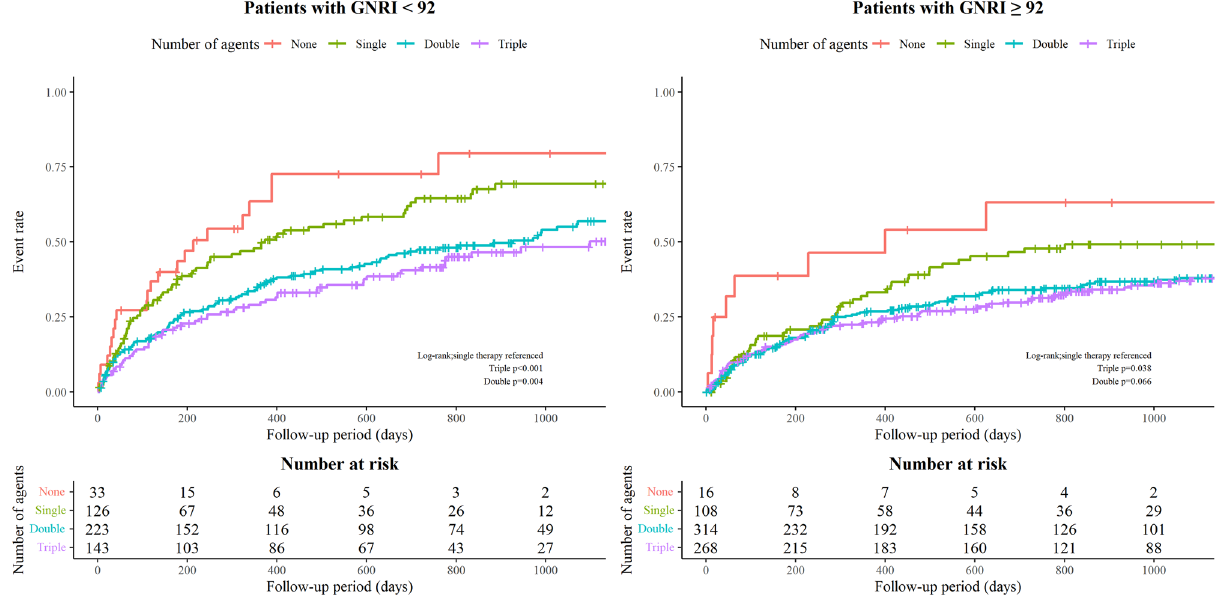
Figure 4. Unadjusted Kaplan–Meier curves for the composite outcome (all-cause death and heart failure rehospitalization) in each treatment group (no, single, double, and triple therapy) according to Geriatric Nutritional Risk Index score (GNRI: < 92 vs. ≥